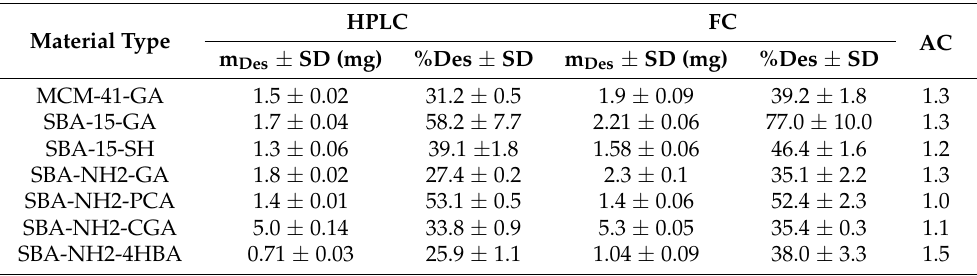
Table 4. The amount of antioxidants desorbed from the SBA ‐ NH2 material determined using the HPLC and FC methods with antioxidant capacity.